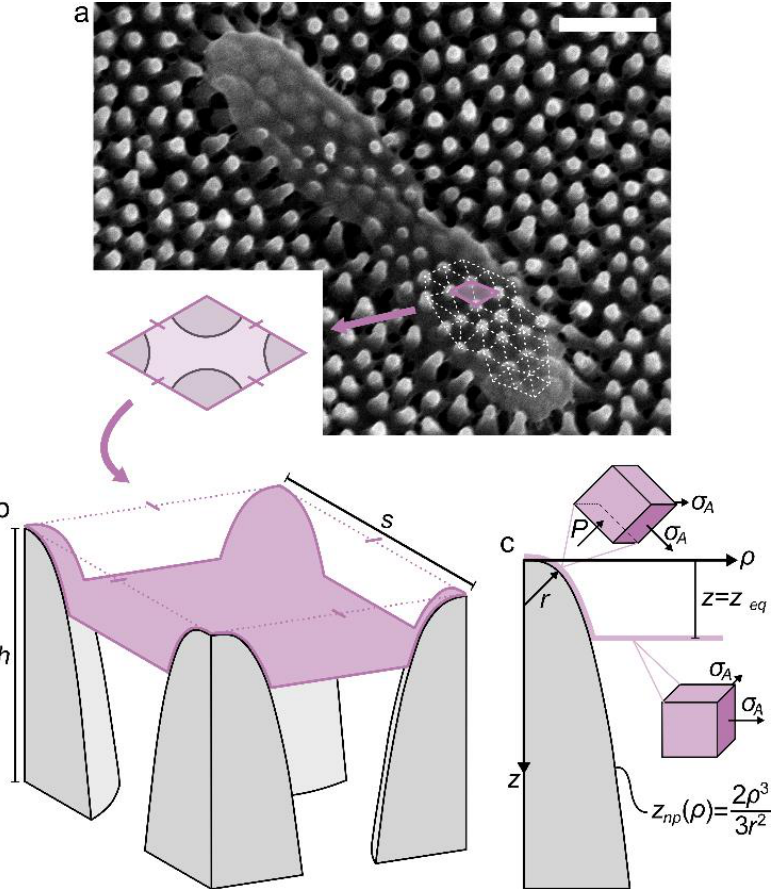
Figure 1. Modelling bacteria-nanopattern interaction by isolating a critical section. ( a ) Micrograph of a Psuedemonas aeruginosa bacteria on a P. claripennis wing, demonstrating ‘entrapment’ in the center of the cell. Scale bar is 500 nm; ( b ) Critical section isolated through the center of four adjacent nanopillars. The section has an edge length equivalent to the center spacing between nanopillars, s , and an initial area, A 0 . Each edge of A 0 can only move in a vertical plane which is coincident with that edge. The nanopillars have a height, h ; ( c ) Cross-section of a single nanopillar with an adhered envelope. Nanopillars are described by the smooth, non-piecewise function z np ( ρ ) = 2 ρ 3 /3 r 2 , where r is a quasi-tip radius. The envelope is adhered at equilibrium sinking depth, z eq . Contact and suspended regions of the cell experience different states of stress, indicated by stress elements noting in-plane biaxial tensile stress ( σ A ) and out-of-plane compressive contact pressure ( P